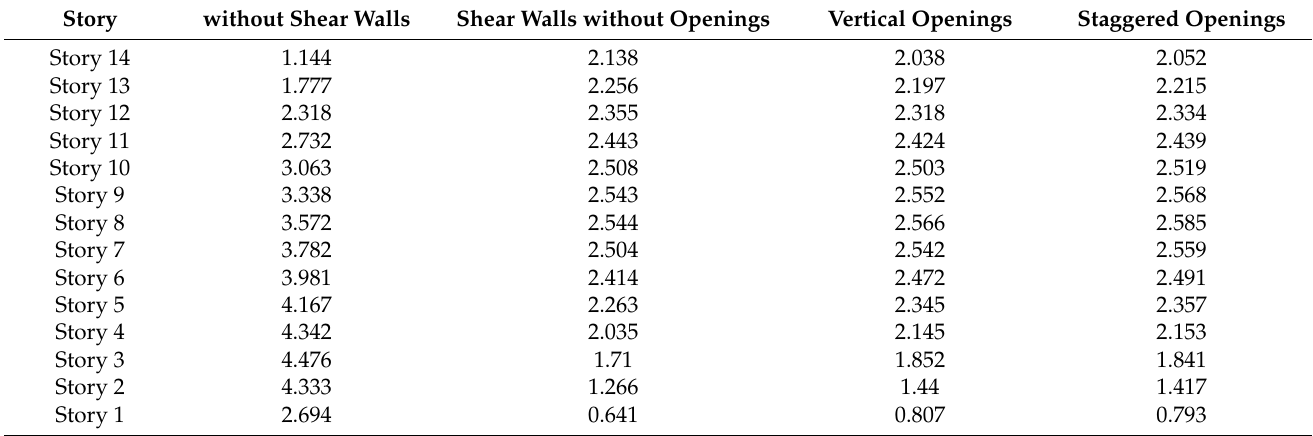
Figure 14. Story drift of the models: static analysis and Y-direction (mm). Tables 12 and 13 and Figures 15 and 16 demonstrate the story drifts in the case of response spectrum analysis (RSA) in the (X&Y) direction. The results show that the max- Table 12. Comparison of the story drift, response spectrum, and X-direction (mm). imum drift seen on the third floor due to the building without shear walls is 4.476 mm in X-direction and 4.6 mm in Y-direction. It is consequently observed that the maximum drift story of the building with shear walls seen on the eighth floor is 2.544 mm, 2.566 mm, and 2.585 mm for the building ’ s vertical and staggered opening, respectively, in X-direction. However, shear walls without openings have a 2.573 mm thickness, while shear walls with vertical and staggered openings in the Y-direction have 2.614 mm and 2.63 mm thick- nesses, respectively.